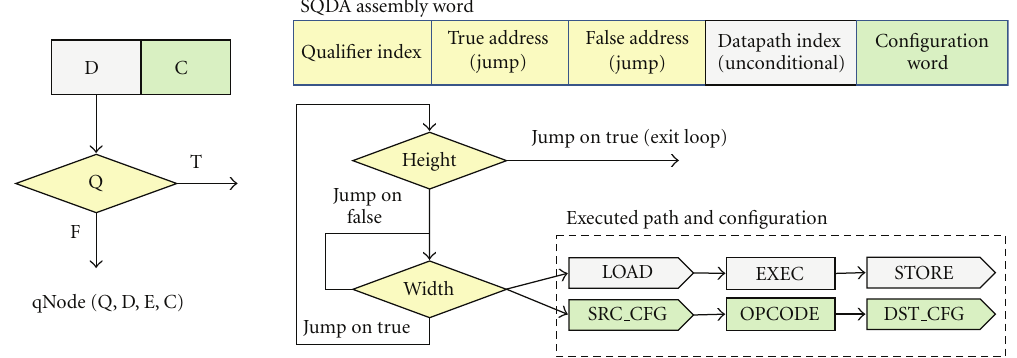
Figure 7: Adding configuration data to the qNode and SQDA to support coarse-grained